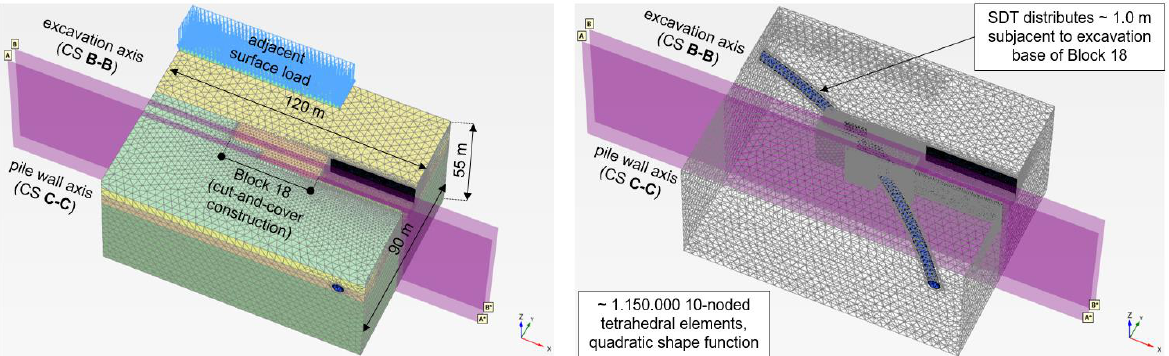
Fig. 15. Overview of entire 3D model (left) and 3D FE mesh